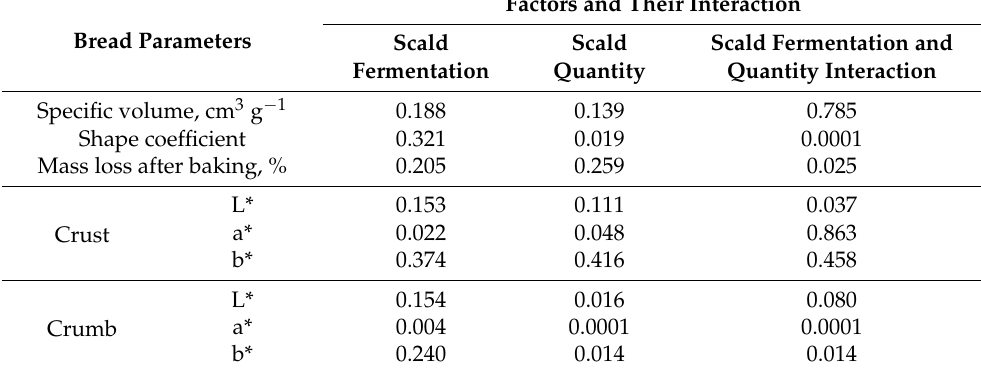
Table 6. Influence of analysed factors (fermentation and quantity of the scald, and their interaction) on bread specific volume, porosity, shape coefficient, mass loss after baking, and crust and crumb colour coordinates. Factors and Their Interaction Bread Parameters Scald Scald Scald Fermentation and Fermentation Quantity Quantity Interaction Specific volume, cm 3 g − 1 0.188 0.139 0.785 Shape coefficient 0.321 0.019 0.0001 Mass loss after baking, % 0.205 0.259 0.025 L* 0.153 0.111 0.037 a* 0.022 0.048 0.863 Crust b* 0.374 L* 0.154 0.016 0.080 a* 0.004 0.0001 0.0001 Crumb b* 0.240 0.014